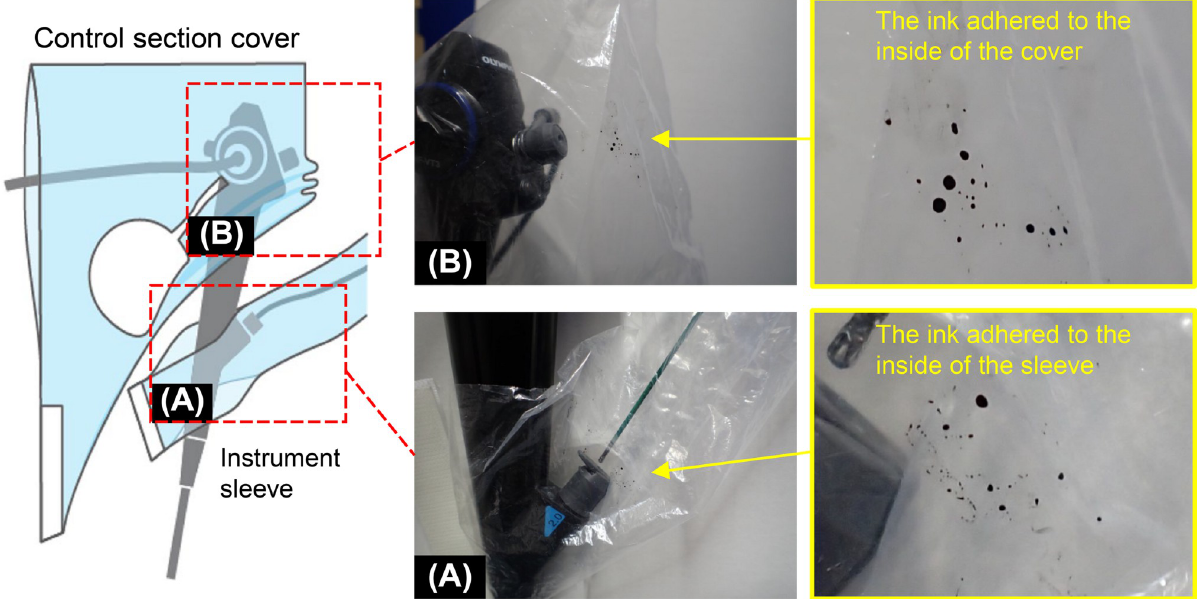
Fig 5. Evaluation of instrument sleeve and control section cover. (A) Ink that is released when the instrument is removed from the instrument channel of the endoscope adheres to the inside of the instrument sleeve (yellow arrow). An enlarged view of the adhered area is shown (yellow box). B: Ink released when pressing the suction button on the endoscope control unit adheres to the inside of the control section cover (yellow arrow). An enlarged view of the adhered area is shown (yellow box).